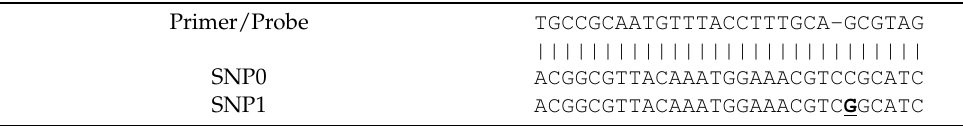
Table 2. H. influenzae 3TEC-PCR wild-type forward primer/probe sequence with complementary targets of the SNP0 and SNP1 synthetic